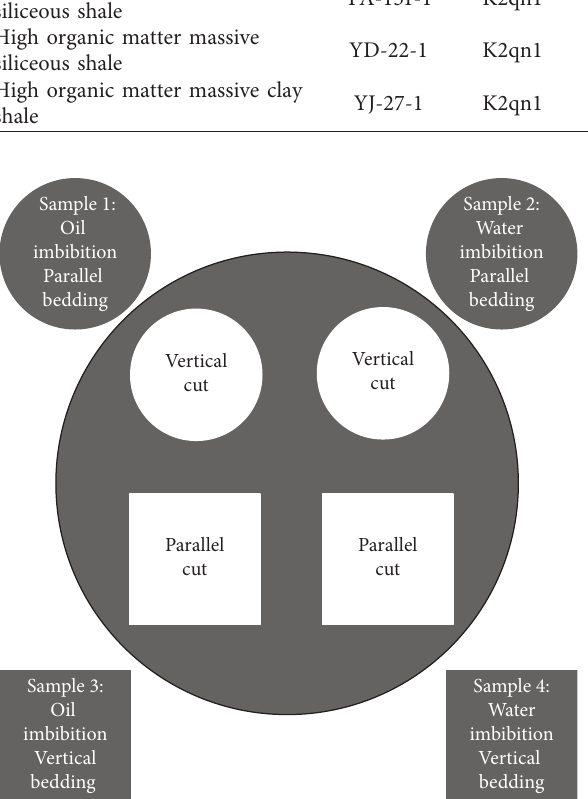
Figure 2: Shale oil reservoir sample cutting method.